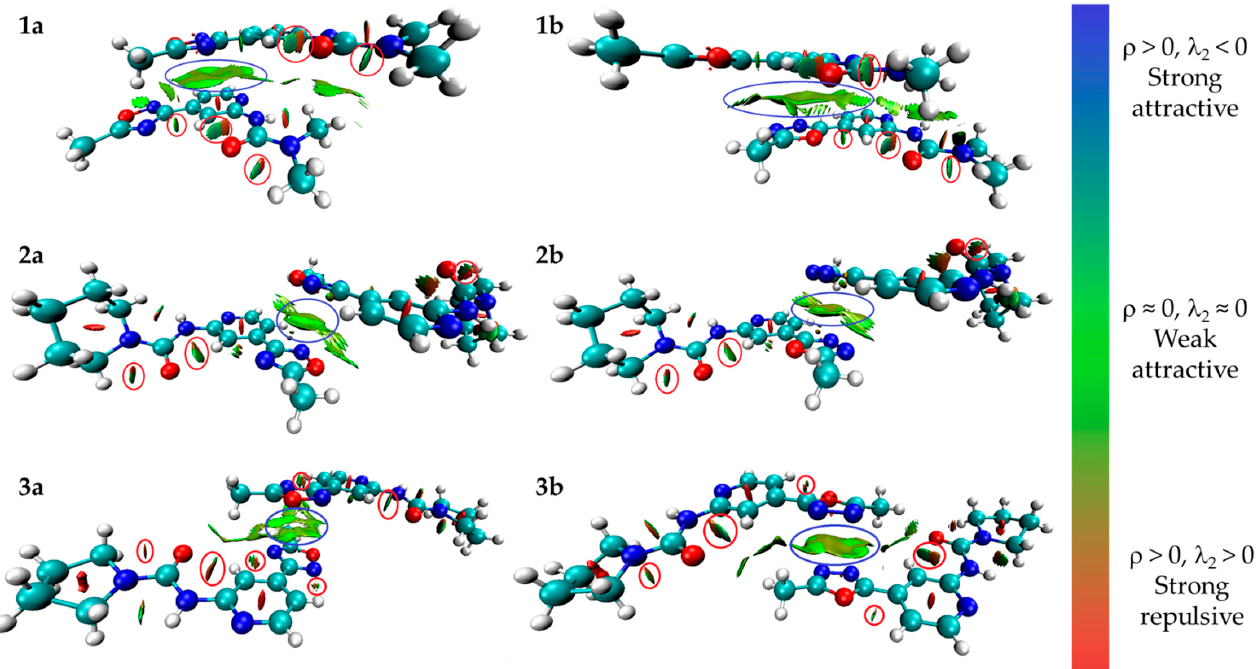
Figure 7. Visualization of various noncovalent interactions involving oxadiazole moieties in 3D using an NCI analysis technique for dimeric associates of ( 1 – 3 ) a,b .